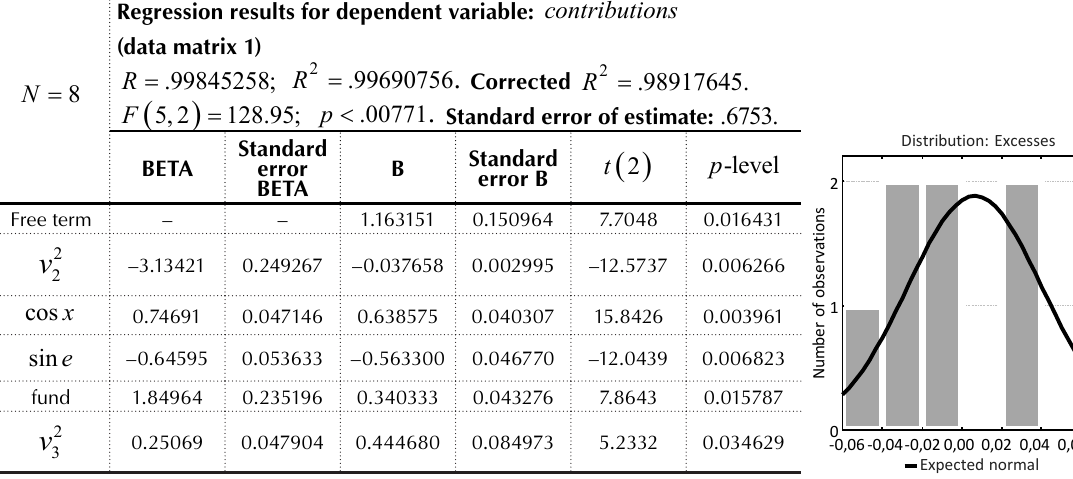
Table 1c. The results of regression of operating costs of the Investor Compensation Fund (Bulgaria) ( ) e from the volume of the fund ( ) x Regression results for dependent variable: costs (data matrix 8 N =